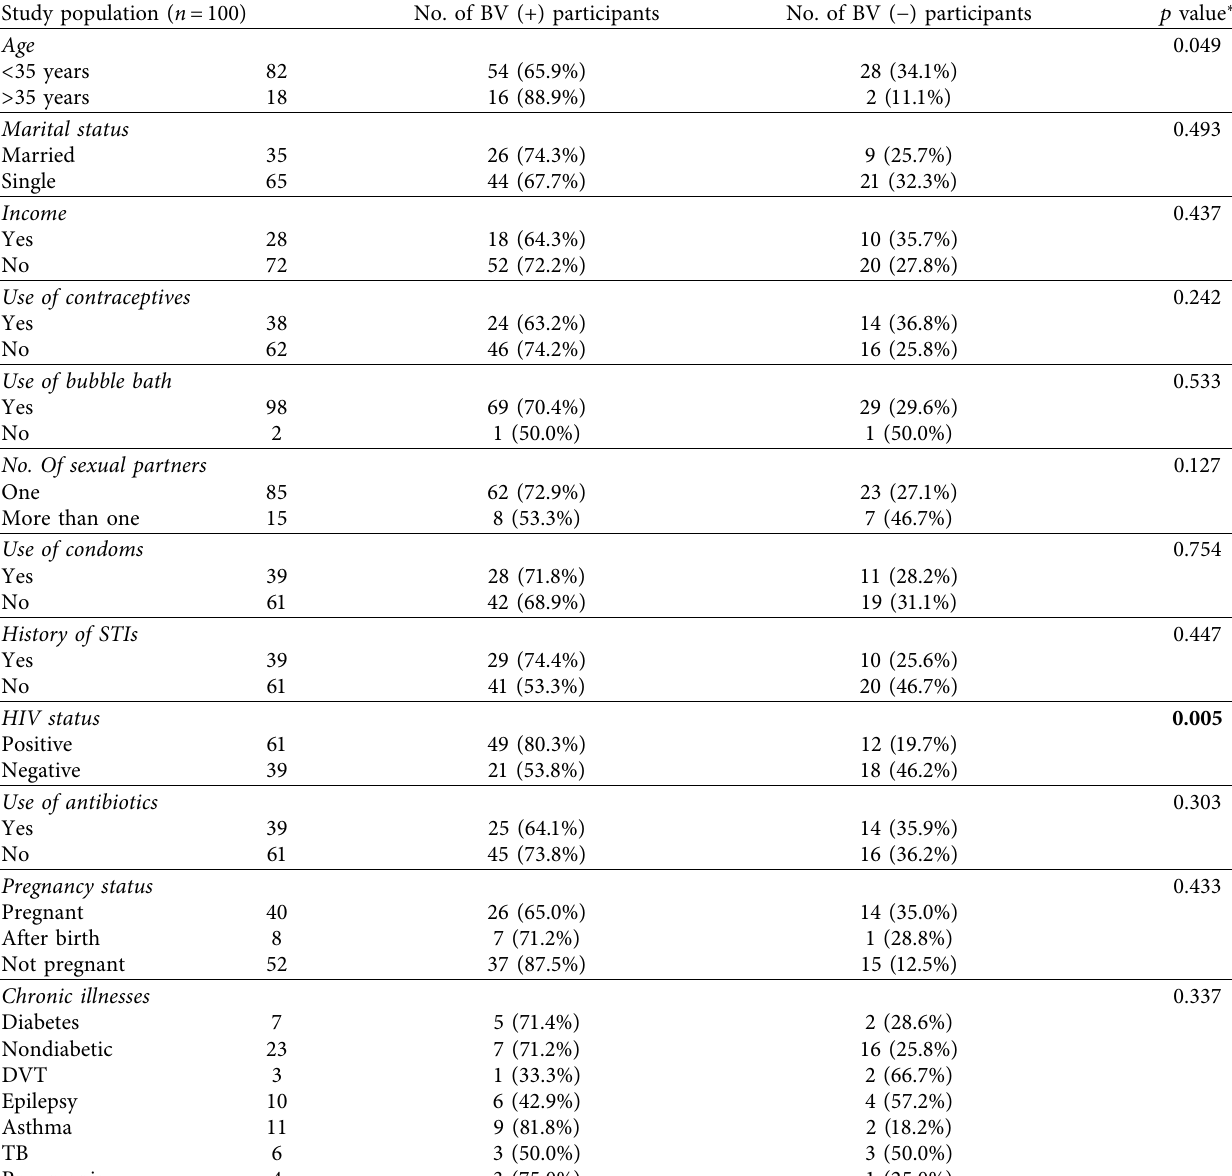
Table 1: Demographic and clinical characteristics of the study